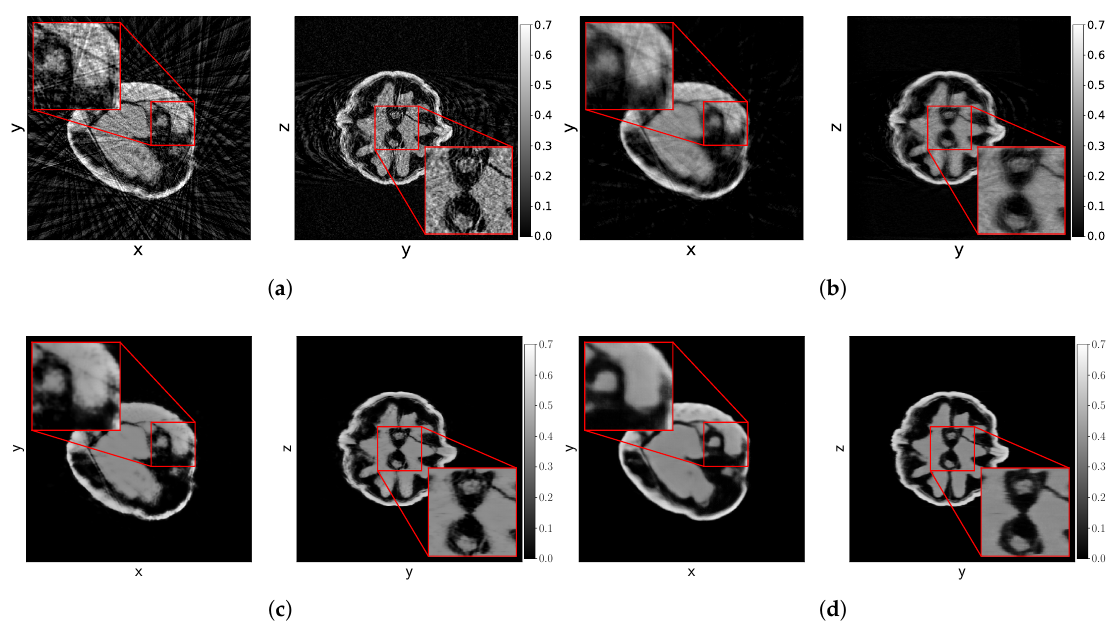
Figure 9. Slices z = 0 and x = 0 of several reconstruction methods of the high-dose dataset of the 21 st walnut with 32 projection angles. ( a ) FDK HN . ( b ) SIRT + ( d ) MSD-net